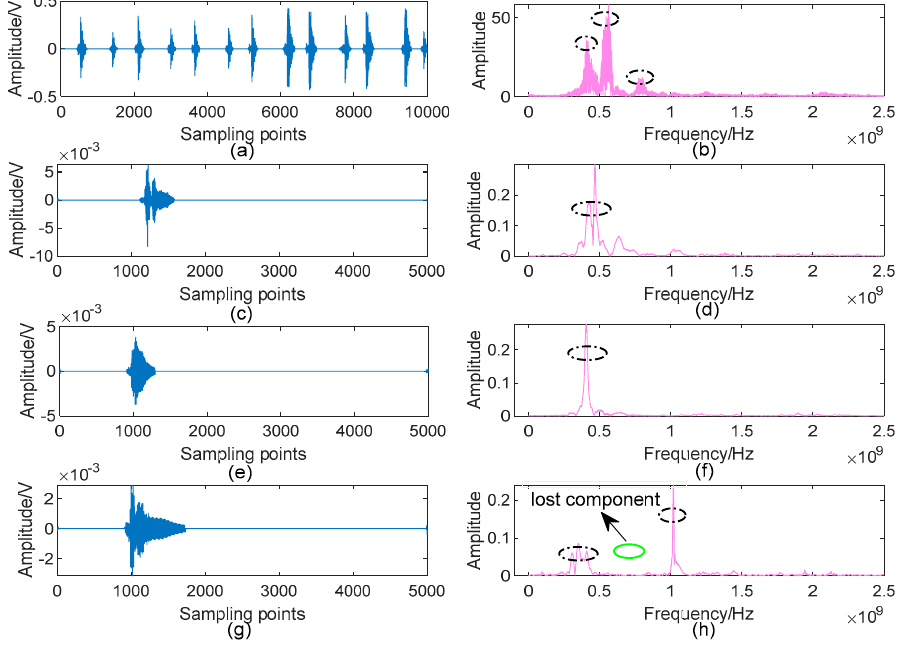
Figure 14. Denoised UHF PD signals by AVMDSSA: ( a ) Denoised signal of Type 1; ( b ) Spectrum of ( a ); ( c ) Denoised signal of Type 2; ( d ) Spectrum of ( c ); ( e ) Denoised signal of Type 3; ( f ) Spectrum of ( e ); ( g ) Denoised signal of Type 4; ( h ) Spectrum of ( g ). Detected PD components in each spectrum are marked with black dash-dotted ellipse, and the lost components in ( h ) is marked by green solid ellipse.